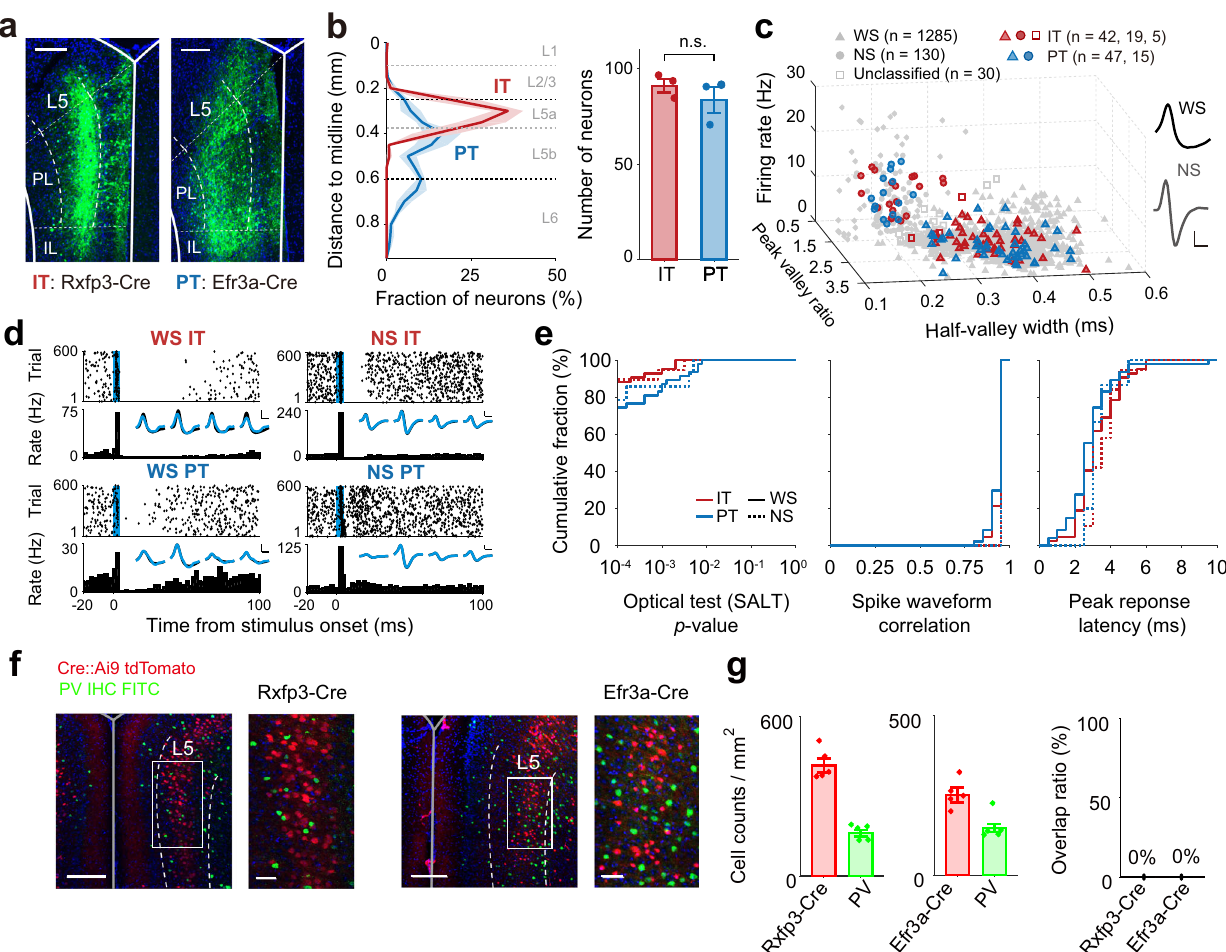
Fig. 2 Optical tagging and unit classi fi cation. a Example coronal brain sections (representative of 14 Rxfp3-Cre and 12 Efr3a-Cre mice) showing ChR2- eYFP expression (green). Dashed lines indicate borders of layer 5. Scale bar, 200 μ m. b Laminar distributions of fl uorescence-expressing cells (50 μ m bins; left) and total cell counts from n = 3 independent brain sections (right; p = 0.397, t -test). Shading and error bars, SEM across n = 3 animals; circles, individual animal data. c Neurons were classi fi ed as wide-spiking (WS; fi lled triangles) or narrow-spiking (NS; fi lled circles) neurons (open squares, unclassi fi ed neurons) based on physiological characteristics. Red and blue, optogenetically tagged IT and PT neurons, respectively (gray, untagged neurons). Inset, averaged spike waveforms of example NS and WS neurons. Calibration, 250 μ s and 50 μ V. d Example responses of optically-tagged IT and PT neurons to light stimulation. Top, spike raster plots; each row is one trial and each dot is one spike. Bottom, peri-stimulus time histograms. Time 0 denotes the onset of 5-ms light stimulation (blue bar). The averaged spike waveforms of spontaneous (black) and optically driven (blue) spikes recorded through four tetrode channels are shown superimposed (inset). Calibration, 250 μ s and 50 μ V. e Cumulative plots for SALT-test p value (left), spike waveform correlation between spontaneous and optically-driven spikes (middle), and peak response latency since laser onset (right) for WS IT, WS PT, NS IT, and NS PT neurons ( n = 42, 47, 19, and 15, respectively). f Example coronal brain sections from Rxfp3-Cre (left) and Efr3a-Cre (right) mice showing tdTomato (red, crossed with Ai9) and PV (green, immunostaining) expressions (representative of fi ve Rxfp3-Cre and fi ve Efr3a-Cre mice). Scale bar, left, 200 μ m; right, 50 μ m. g Quanti fi cation of Cre-tdTomato and PV expressions (mean ± SEM across fi ve animals; circles, individual animal data). Note that there is no overlap between Cre-tdTomato and PV